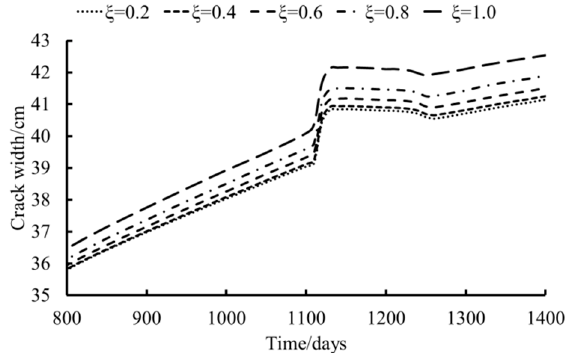
Figure 9. Crack-width–time curve under different discharge speeds.